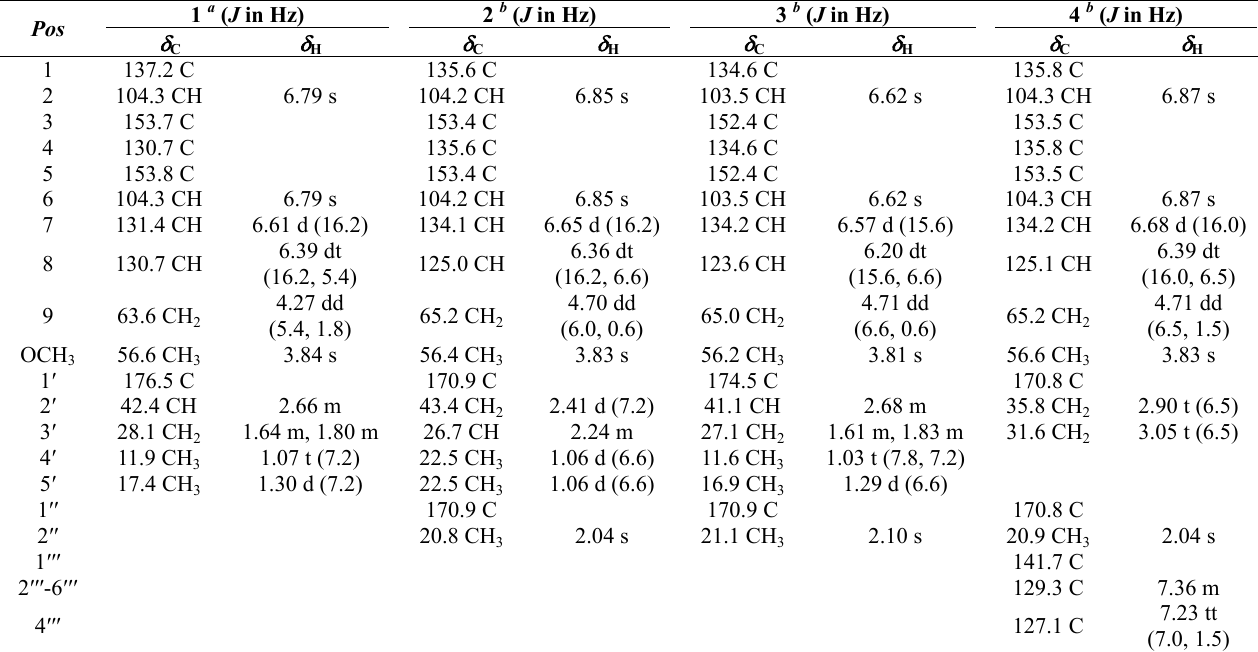
Table 1. 1 H and 13 C-NMR Spectroscopic Data for dichrocephols A–D ( 1 – 4